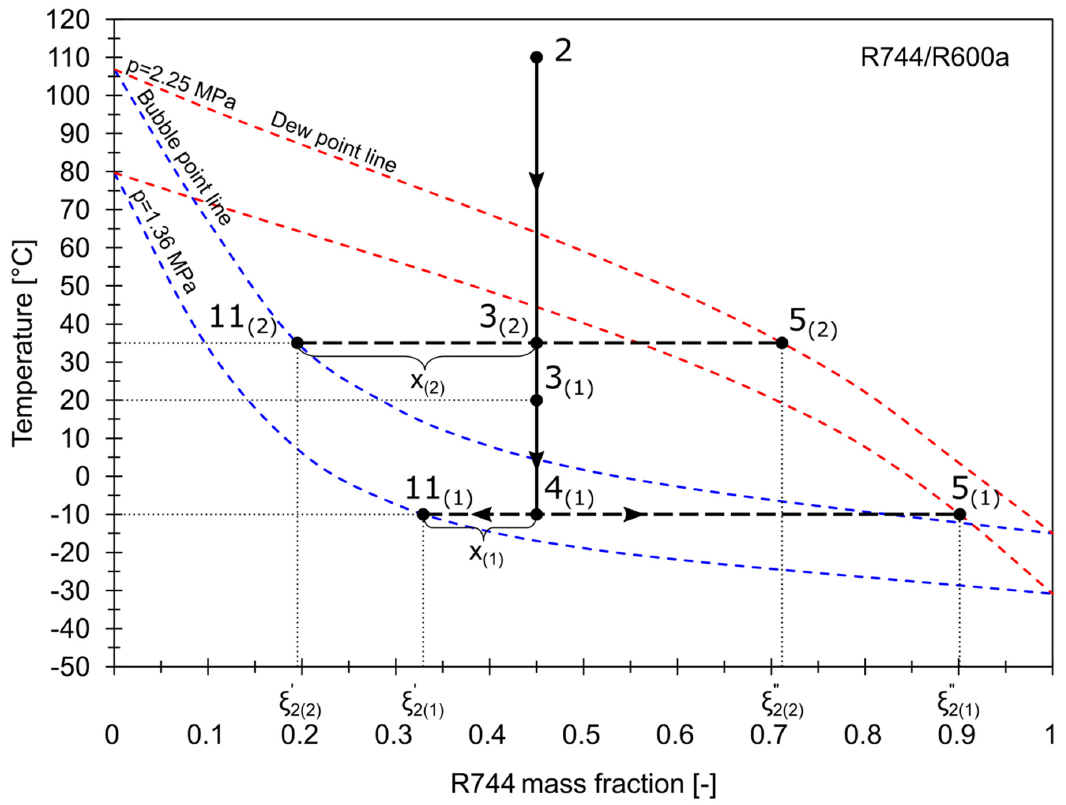
Figure 6. The influence of condensing temperature and RHX on the vapor quality.